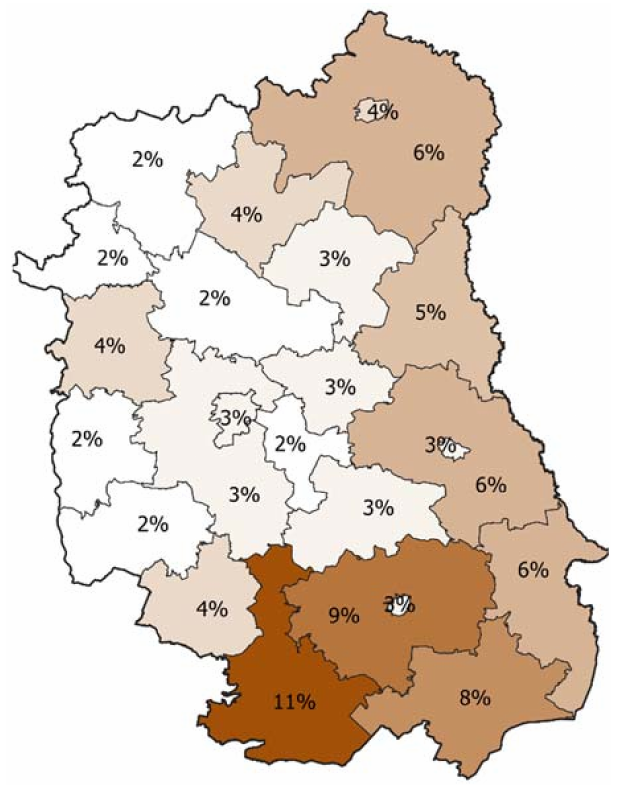
Figure 4. Estimated sale shares of stored by poviat.